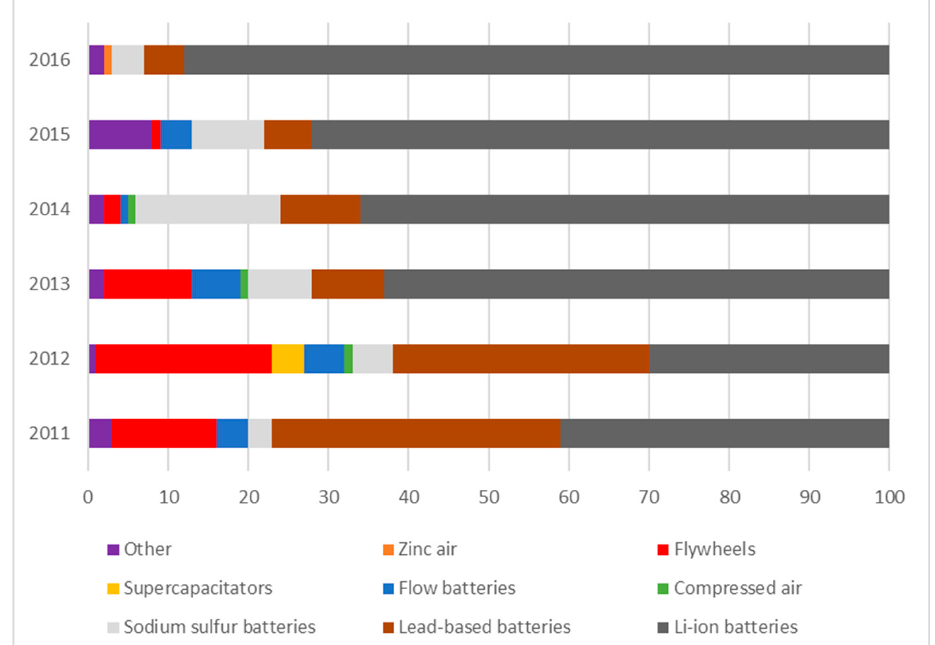
Figure 2. Technology mix in storage installations excluding pumped hydro from 2011 to 2016. Redrawn from [28].